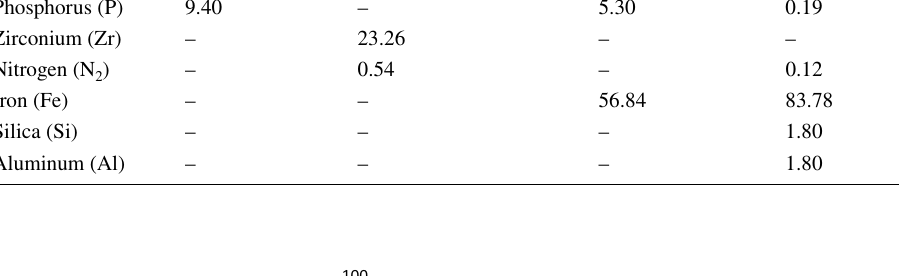
Table 4 Bonding group analysis for FTIR study Bonding group